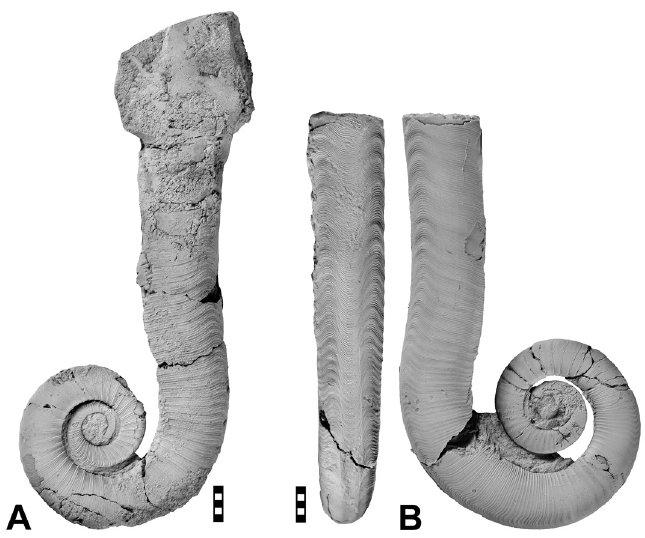
Fig. 63. Lituites kruegeri sp. nov. and L. cf. kruegeri from the Upper Grey Orthoceratite Limestone. A . L. cf. kruegeri – specimen MB.C.30540 (Neben & Krueger Coll.) from Hohensaaten (Brandenburg); lateral view. B . L. kruegeri sp. nov. – holotype MB.C.30539 (Neben & Krueger Coll.) from Werbellinsee (Brandenburg); previously figured by Neben & Krueger (1971: pl. 31 fig. 5); ventral and lateral views. Scale bar units = 1